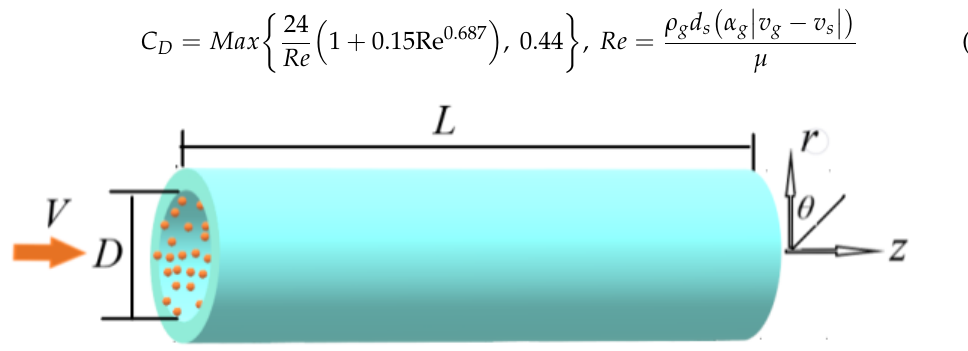
Figure 1. Schematic diagram of gas–solid two-phase flow in a pipe.